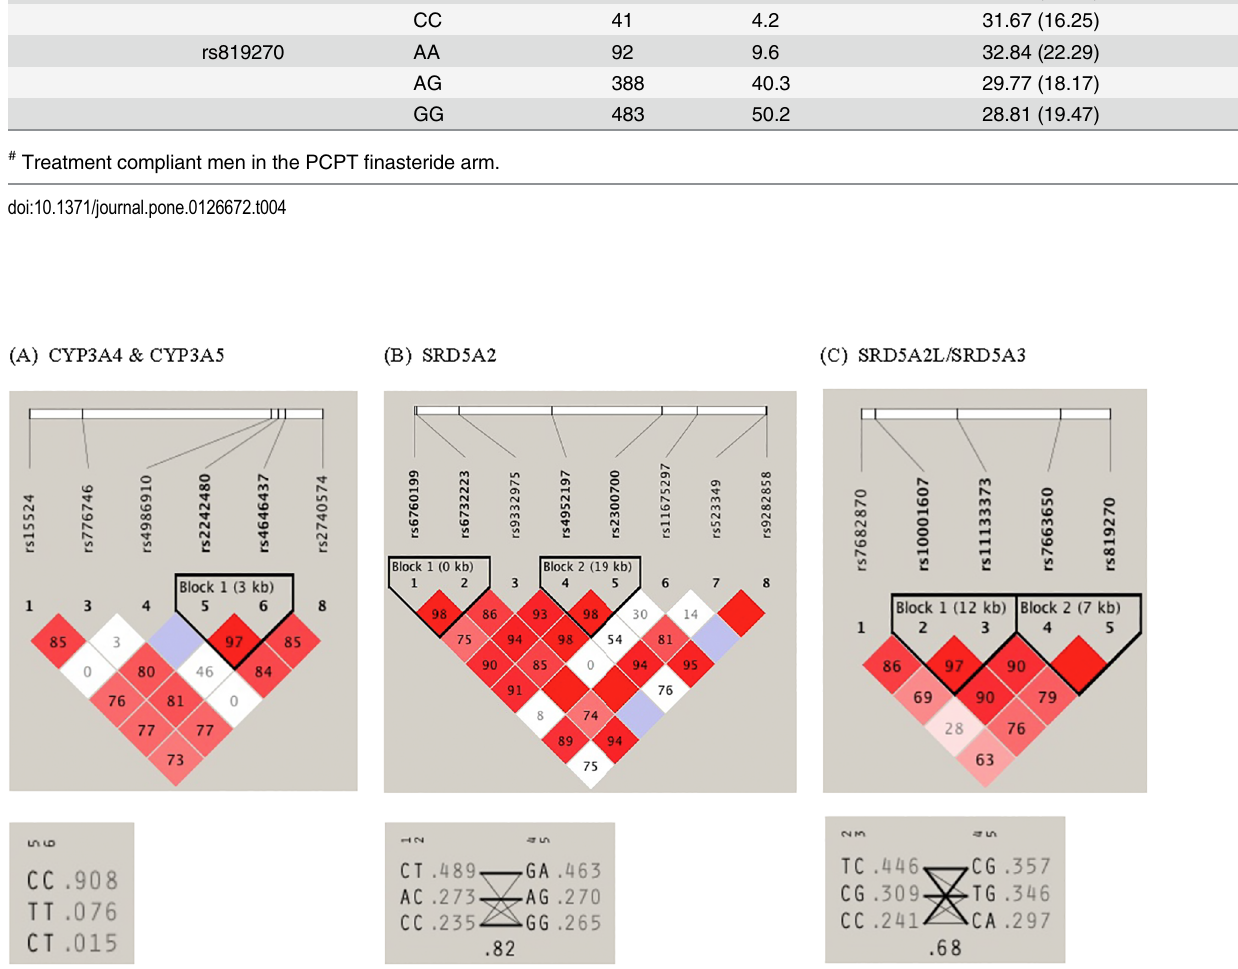
Fig 1. Linkage disequilibrium (LD) pattern and haplotype architecture for (A) CYP3A4 & CYP3A5 ; (B) SRD5A2 ; and (C) SRD5A2L/SRD5A3 genes. The haplotype block structure, as exhibited by Haploview is shown. LD was measured using data from all white subjects in the present study. The haplotype blocks were determined using the criteria described by Gabriel et al. The physical position of each SNP is presented in the upper diagram. Each diamond contains the level of LD measured by Hedrick's multiallelic D 0 between pairs of single nucleotide polymorphisms. Shading shows the magnitude and significance of pairwise LD, with darker shades representing stronger LD; the diamond without a number corresponds to D 0 = 1. Haplotypes for the variations and their population frequency (light gray color) are shown below each haplotype block of the corresponding genes. The SNP numbers across the top of the haplotypes correspond to those in the Haploview plot. D 0 indicates the level of recombination between two blocks and is shown in the crossing area. The connection from one block to the next block is displayed through frequency corresponding to the thickness of the